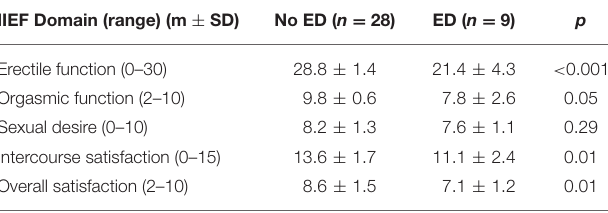
TABLE 2 | IIEF results comparing those with ED to those